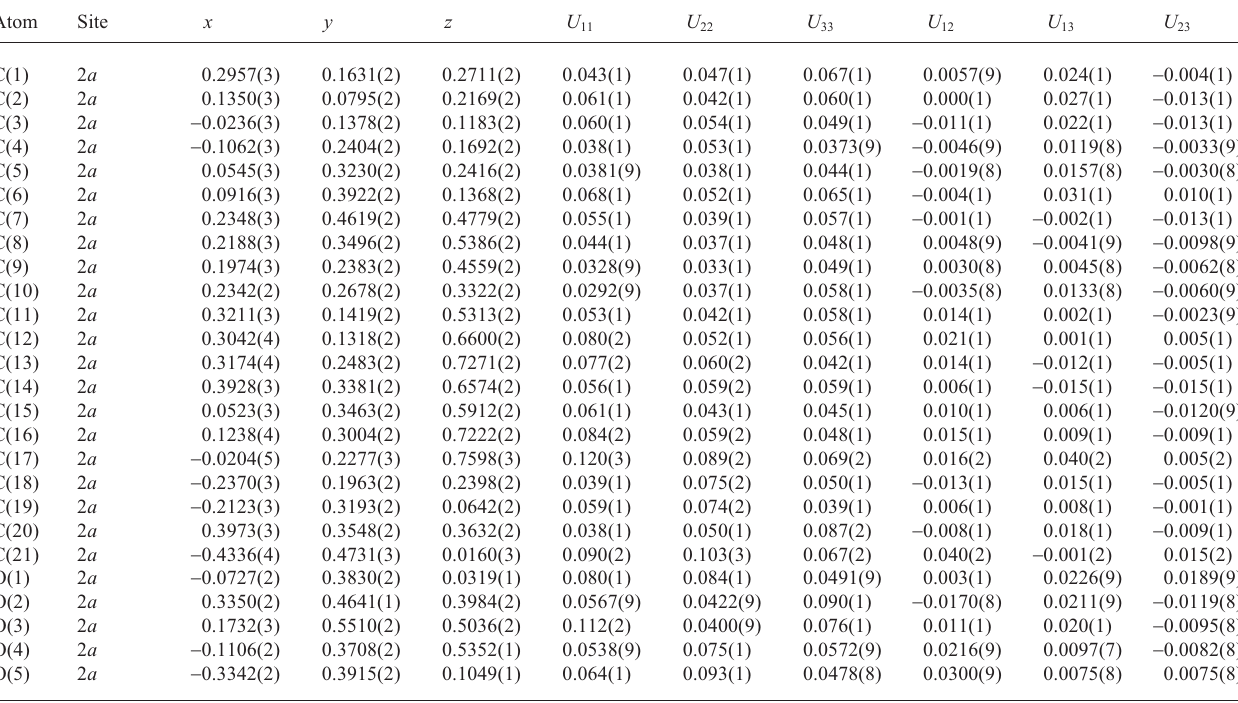
Table 3. Atomic coordinates and displacement parameters (in Å 2 ) .